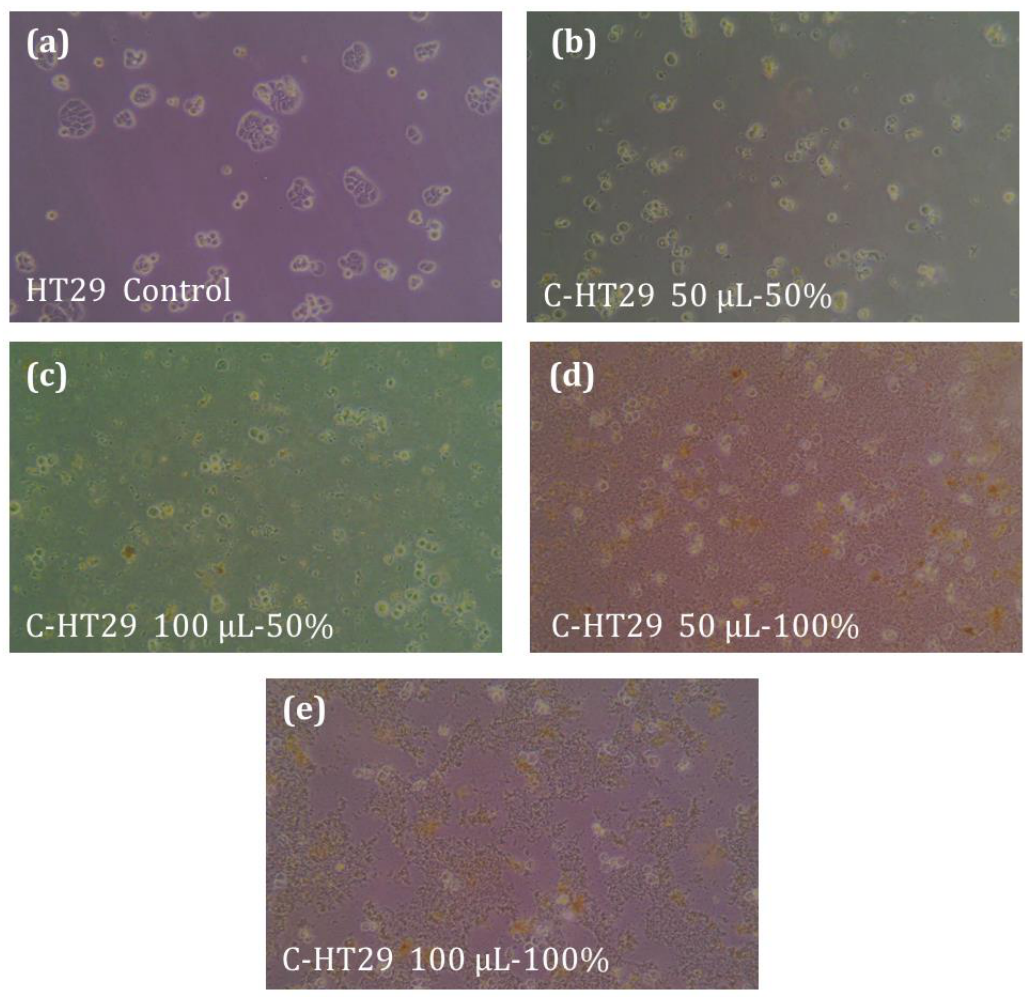
Figure 5. Effect of plant extract on HT29 cancer cell lines. ( a ) The control samples (DMSO); ( b ) 50 µ L of 50% extract; ( c ) 100 µ L of 50% extract; ( d ) 50 µ L of 100% extract; ( e ) 100 µ L of 100% extract. The figures are at magnification 400×.